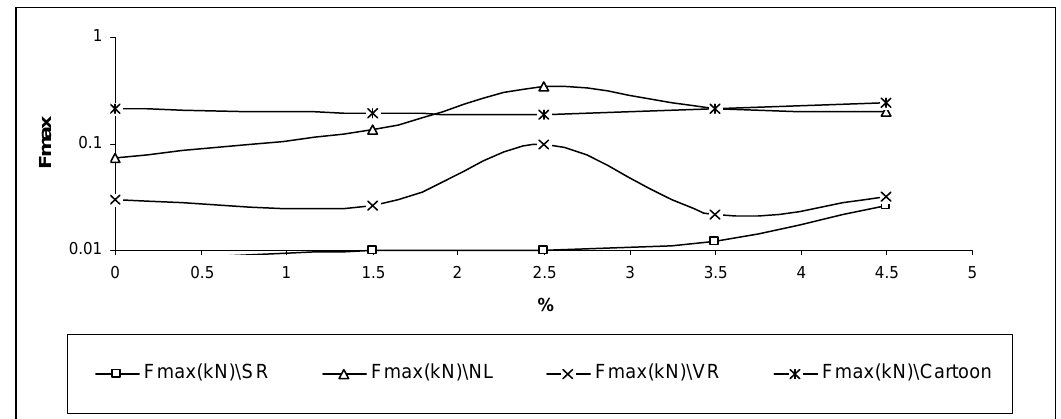
Fig. 18: Shear strength of the samples involved. Table 1: Main mechanical properties of SR, NL, VR, cartoon samples for F